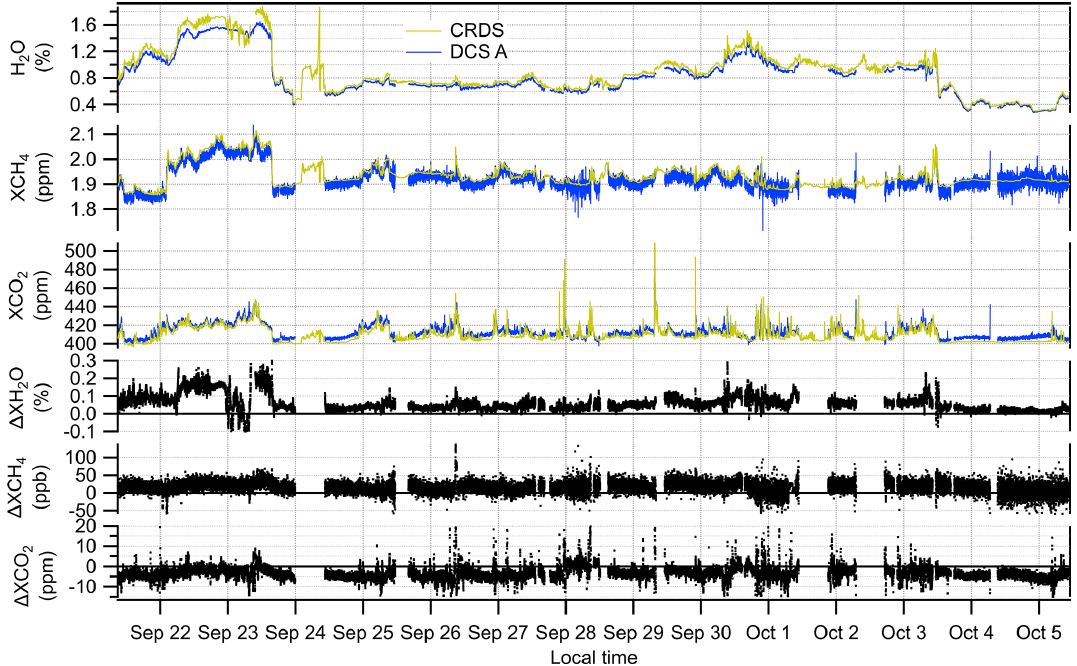
Figure 9. Comparison between the open-path DCS A data (blue) and the point CRDS data (gold) for H 2 O, dry CH 4 , and dry CO 2 at 32s intervals over 2 weeks. The lower three panels directly plot the corresponding difference between the